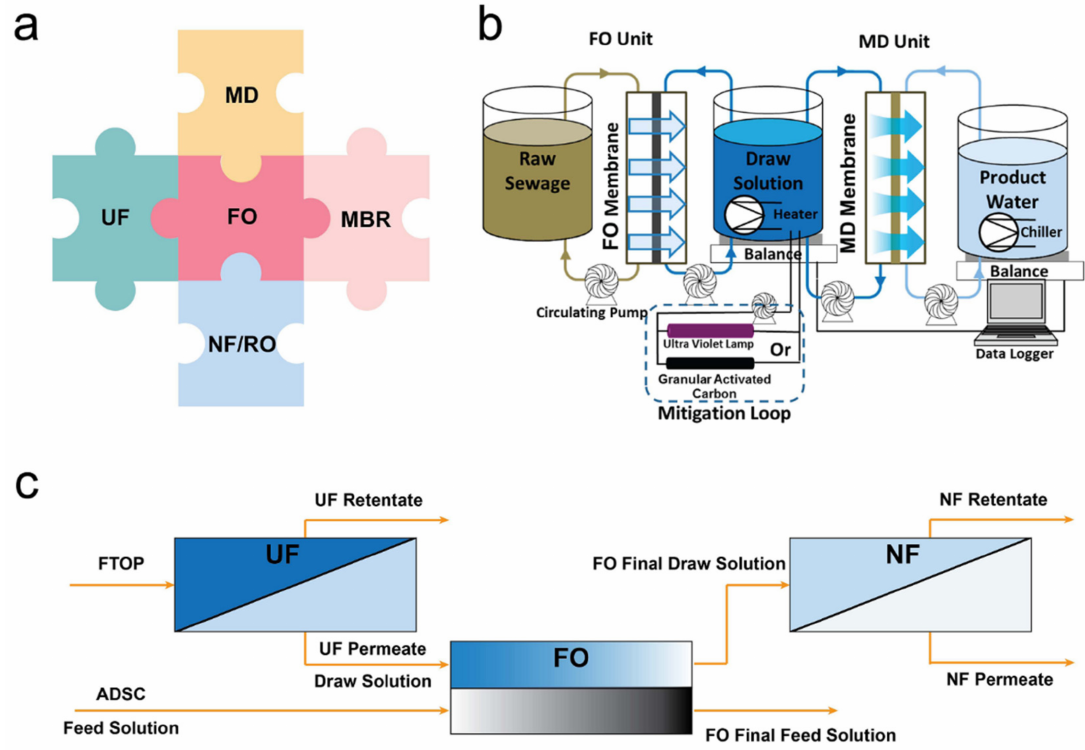
Figure 4. ( a ) Illustration of the integration of FO with other membrane-based technologies, ( b ) schematic diagram of the FO-MD hybrid system with the mitigation loop for the reduction of the concentration of feed contaminants in the draw solution, reprinted with permission from [61], and ( c ) schematic diagram of the UF-FO-NF integrated system, adapted from